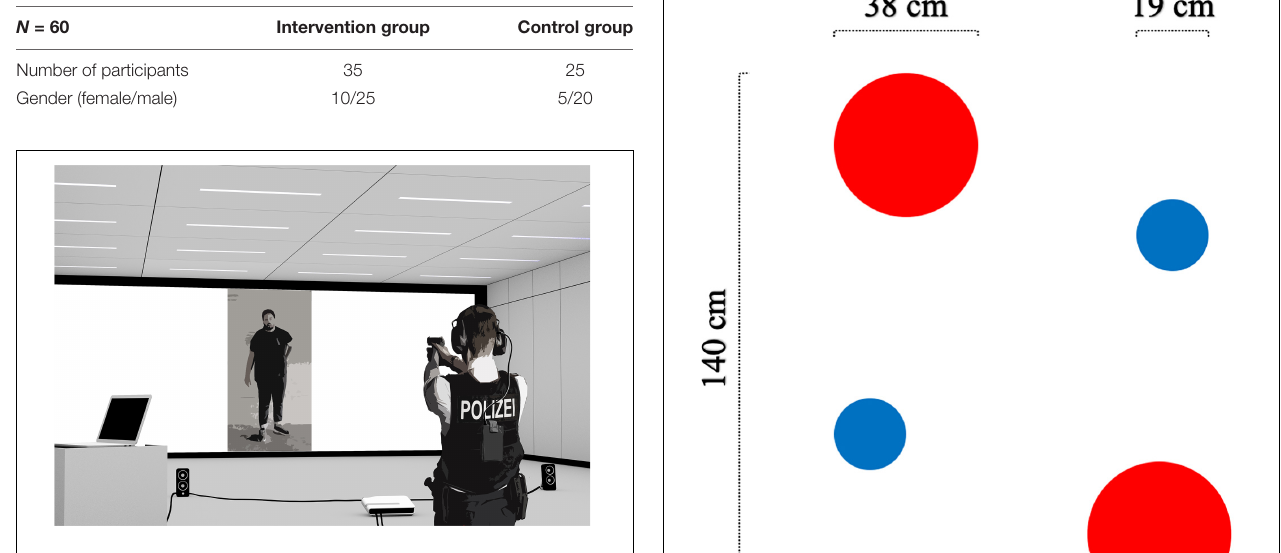
FIGURE 1 | The experimental setup of the pre- and posttest.